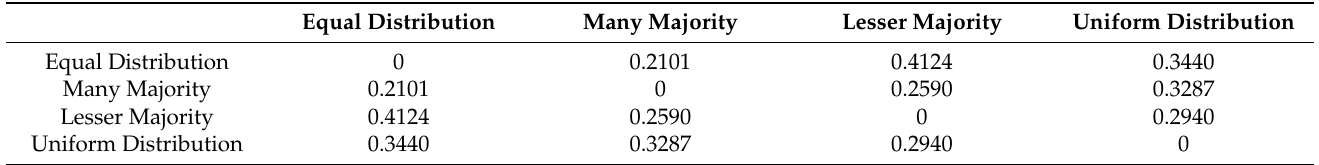
Table 12. JS distance between the chosen